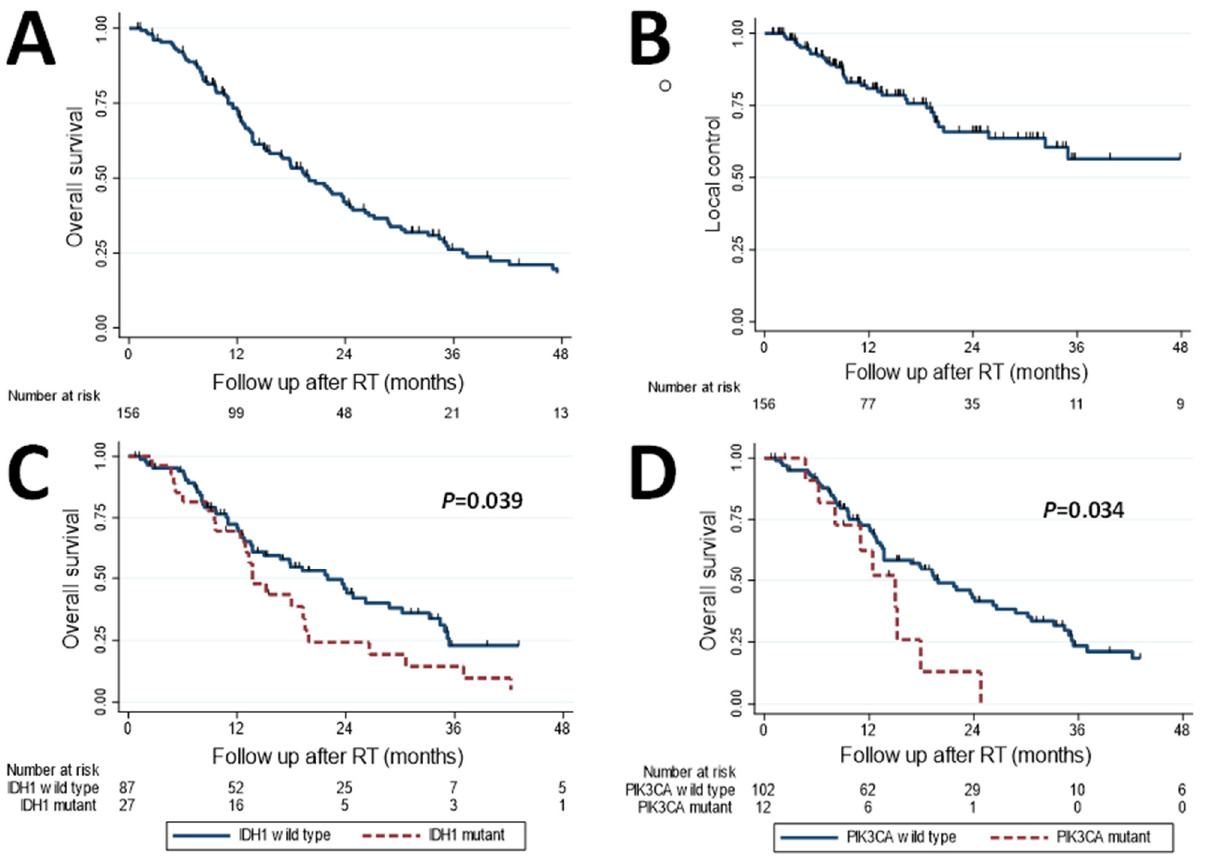
Figure 1. ( A ) Overall survival and ( B ) local control for the entire cohort, and overall survival stratified by ( C ) IDH1 mutational status and ( D ) PIK3CA mutational status.